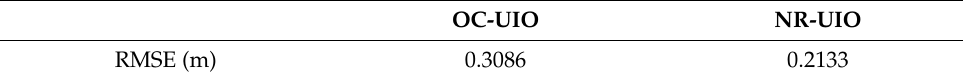
Figure 11. The comparison of the estimated position in x- and y-axes with groundtruth. Table 3. The root mean square errors of OC-UIO and NR-UIO compared with